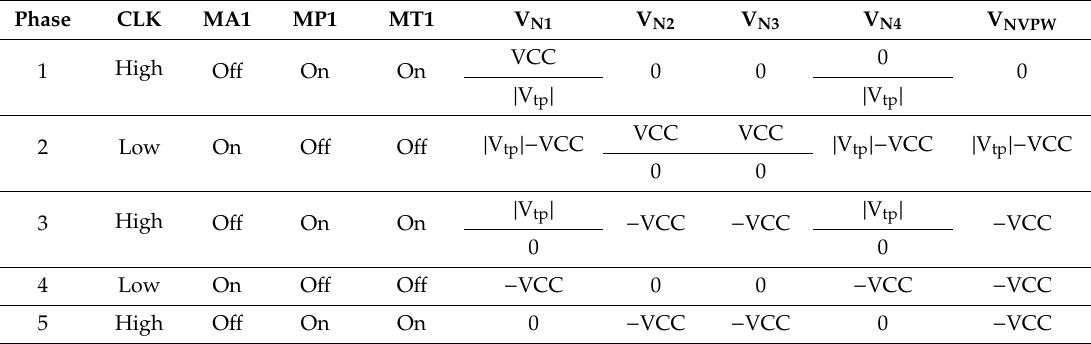
Figure 4. Conventional cross-coupled hybrid pumping circuit using an auxiliary pump unit (Conv 3) [7]. Table 3. Sequential operation of Conv3.